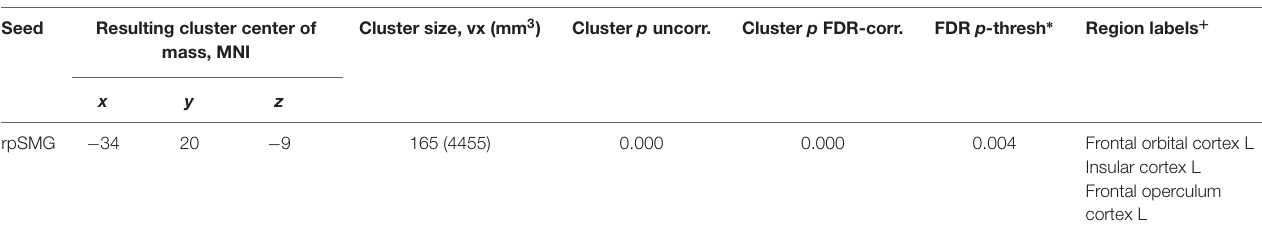
TABLE 5 | Correlation between the severity of space motion sickness and seed-to-voxel